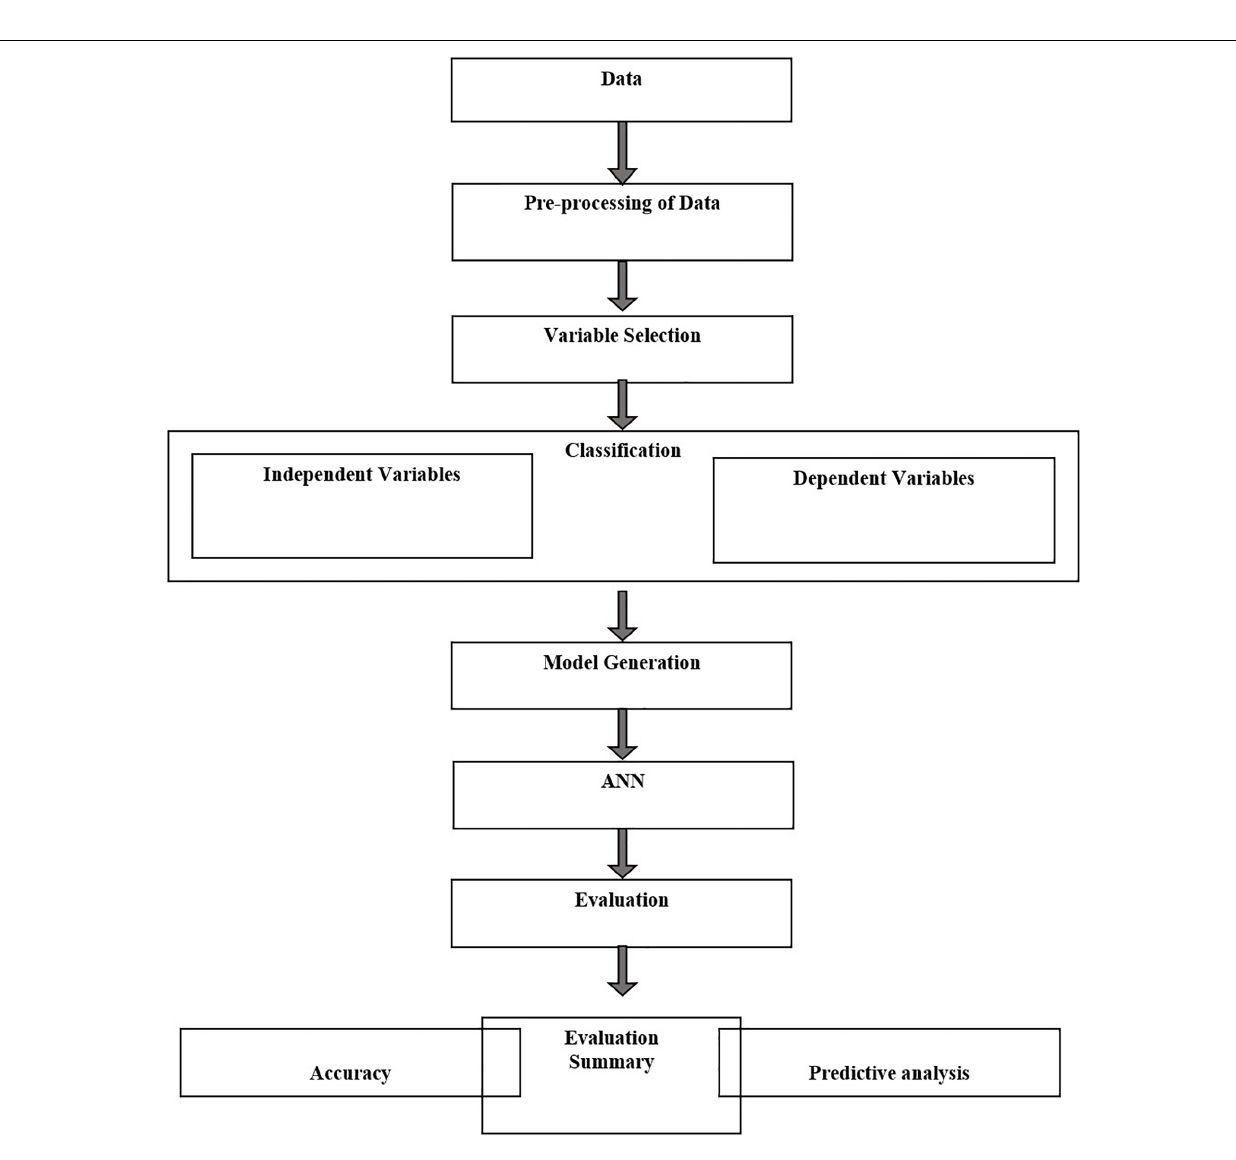
Frontiers in Microbiology |